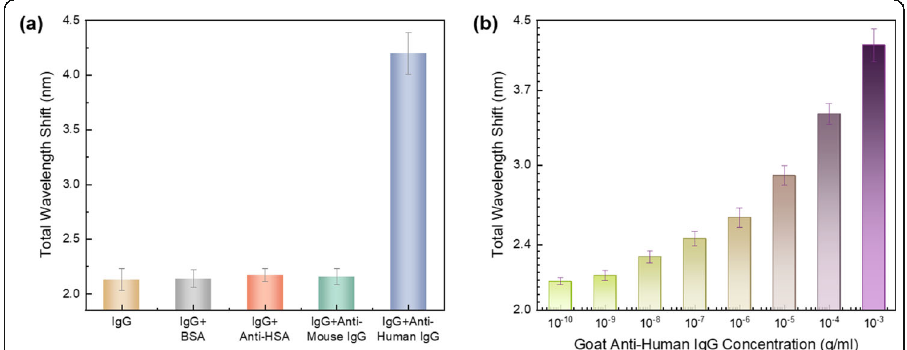
Fig. 6 Effects of specific binding between anti-human IgG and human IgG. ( a ) With 10 − 3 g/ml human IgG coated on the silica wall, WGM wavelength shift responses when LCs are exposed to various proteins (BSA, anti-HSA, anti-mouse IgG and anti-human IgG) at the same concentration of 10 − 3 g/ml. ( b ) WGM spectral shift resulted from antibody-antigen binding events between 10 − 3 g/ml Human IgG and different concentrations of goat anti-human